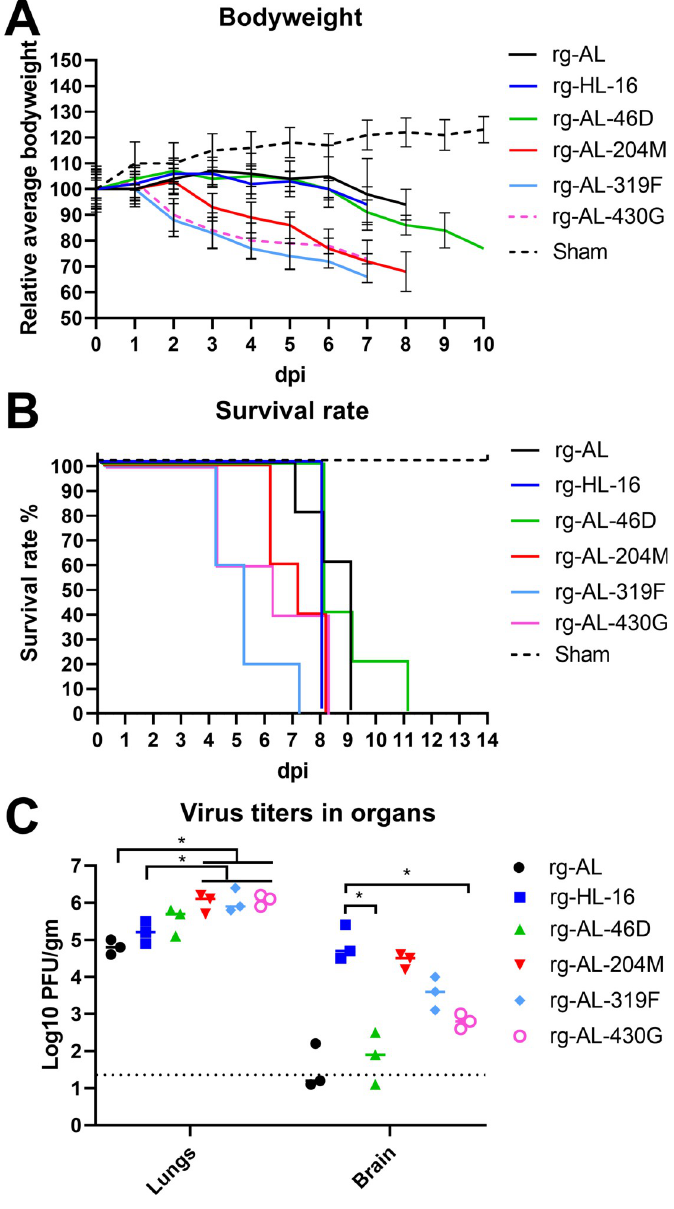
Fig 9. The impact of NA mutations on virus virulence in mice. Mice (n = 8 per group) were inoculated intranasally with 10 5 PFU of the indicated viruses or 50 μ L PBS (sham group). Average bodyweight (A) and the survival curve (B) were determined. Viral loads in lung and brain homogenates were tested by plaque test and were expressed as PFU/ gram (n = 3 per group) (C). highest titers followed by rg-AL-319F then rg-AL-430G and were found in the brain of all mice (n = 3) (Fig 9C). To study the impact of NA mutations on the early immune response, activation status of CD4 + and CD8 + T-cells was measured by flow cytometry 3 dpi in the spleen (S7 Fig). Compared to rg-AL, CD4 + (but not CD8 + ) were activated to significantly higher levels in mice inoculated with rg-AL-204M and rg-AL-319F (p < 0.05). Collectively, viruses with (rg-HL-16) or lacking (rg-AL) these four mutations exhibited a comparably